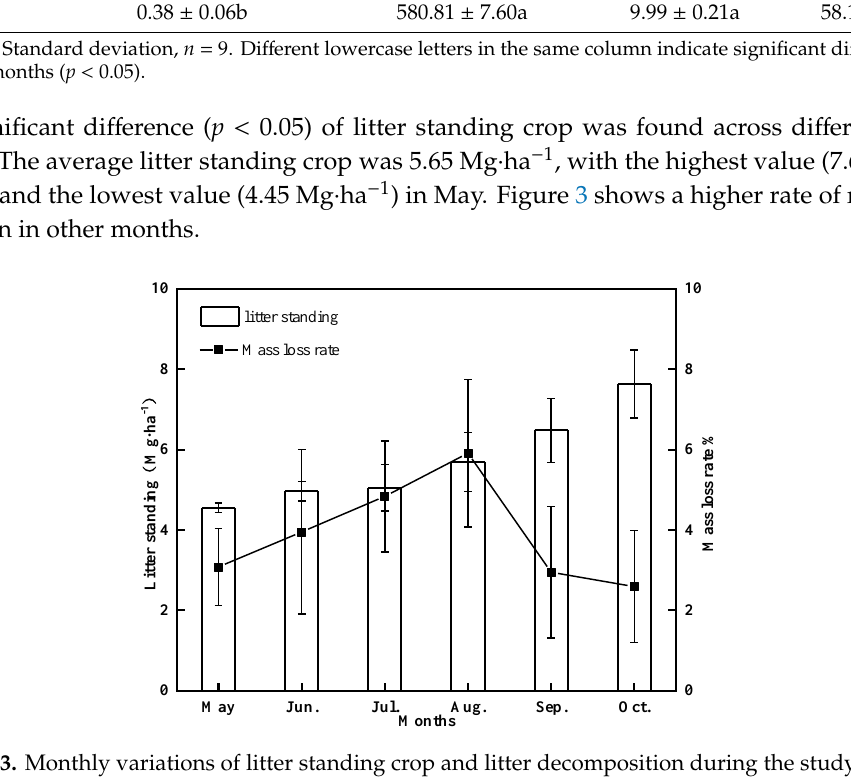
Figure 3. Monthly variations of litter standing crop and litter decomposition during the study period ( n = 9).